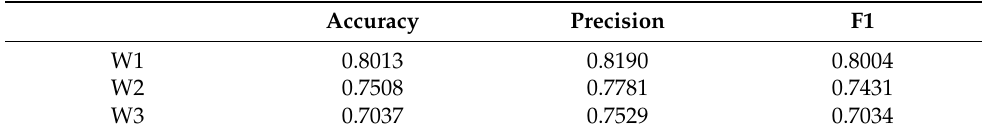
Table 1. Evaluation of the global FL model produced after r = 3, using Worker 1’s (W1), Worker 2’s (W2) and Worker 3’s (W3) evaluation datasets.